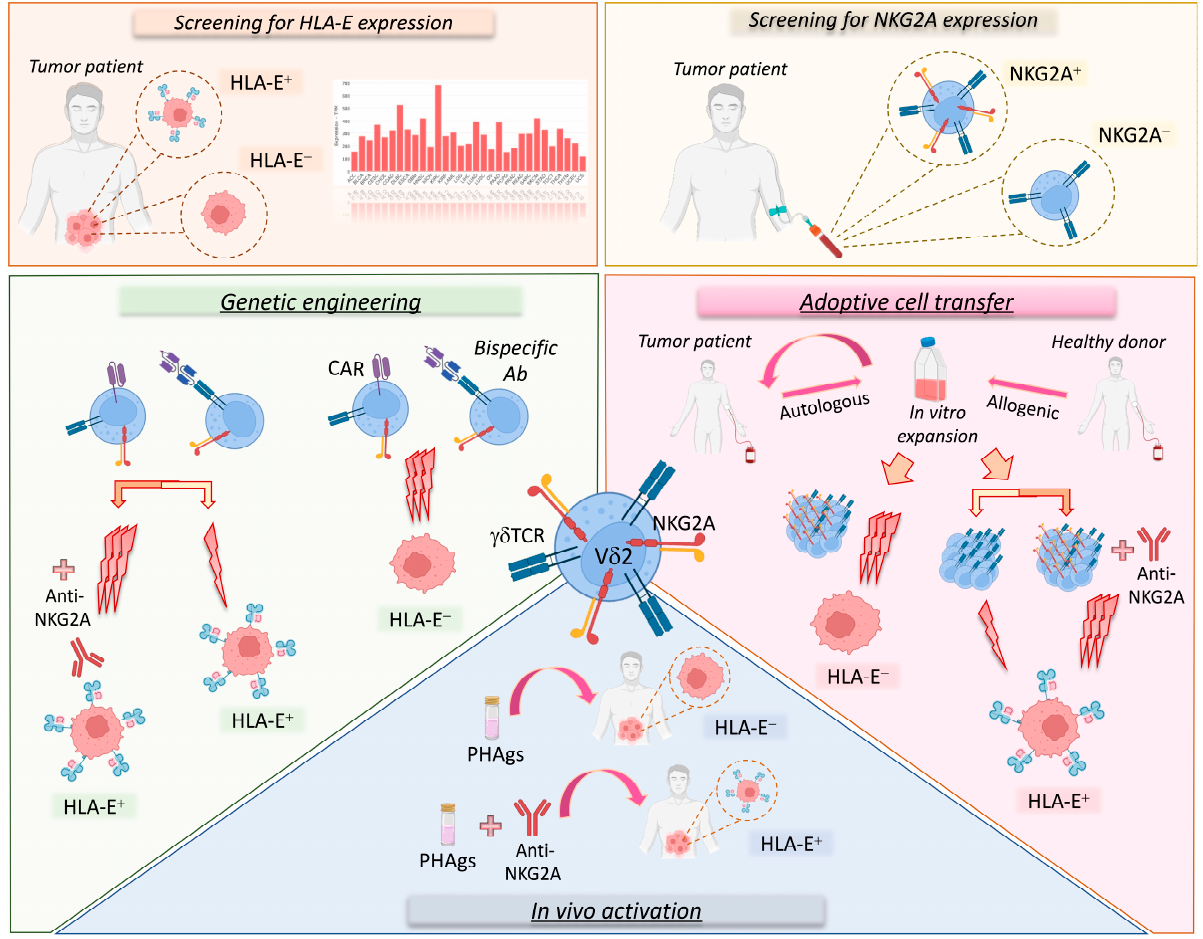
Figure 2. V δ 2 T cell-based immunotherapeutic approaches considering the NKG2A-HLA-E immune checkpoint axis. Several therapeutic strategies targeting the NKG2A-HLA-E axis on V δ 2 T cells could be used to treat cancer patients. First of all, it is important to evaluate the expression level of HLA-E in the tumor as well as that of NKG2A on V δ 2 T cells (upper panels). In fact, tumors can be characterized by variable levels of HLA-E (orange square; HLA-E transcription levels in various cancer types; RNA-sequencing data for the expression of HLA-E gene are reported as transcripts per million (TPM) and generated by using the Gene Expression Profiling Interactive Analysis 2 (GEPIA2) web server). Moreover, both patients and healthy donors can show variable levels of NKG2A expression on V δ 2 T cells (yellow square). These parameters, along with the possibility of sorting NKGA + or NKG2A − V δ 2 T cells, should be considered in immunotherapeutic strategies (lower panels). In particular, autologous or allogenic V δ 2 T cells can be expanded in vitro for adoptive cell transfer therapy. However, for tumors lacking HLA-E, it would be more suitable to use NKG2A + V δ 2 T cells, as they show higher cytotoxic (3 lightning bolts) potential, while for tumors expressing HLA-E, it would be more appropriate to use NKG2A + V δ 2 T cells in combination with anti-NKG2A mAbs or in alternative NKG2A − V δ 2 T cells could be used with lower cytotoxic (1 lightning bolt) capability (pink area). Analogously, in genetic engineering approaches (green area) based on CAR- γδ T cells or bispecific antibodies, the use of NKG2A + V δ 2 T cells against HLA-E + tumors would be optimal only in the presence of the anti-NKG2A mAb. However, additional investigations are needed to establish the expression of NKG2A on engineered V δ 2 T cells. Finally, for the in vivo activation of V δ 2 T cells (blue square), PhAgs could be used alone or in combination with anti-NKG2A mAbs for cancer patients with low or high levels of HLA-E,